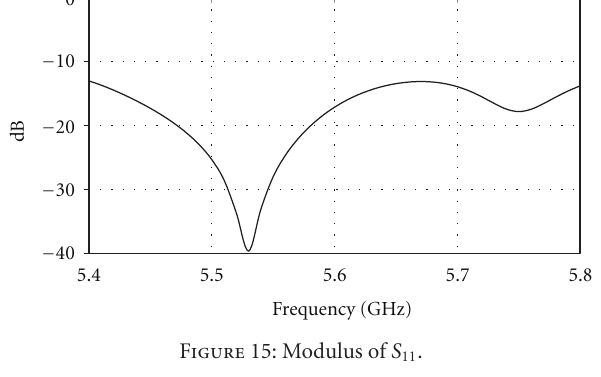
Figure 15: Modulus of S 11 .